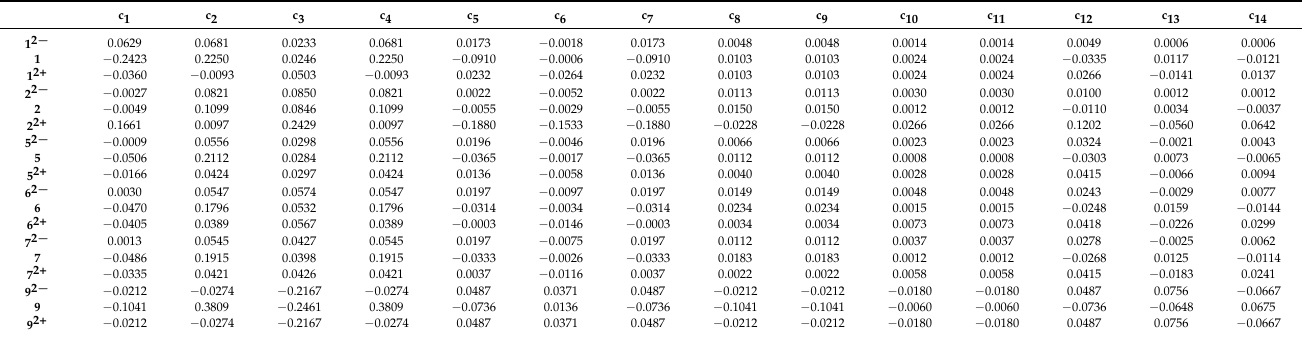
Table 2. CREs in units of | β | for quasicirculenes 1 , 2 , 5 − 7 , 9 and their double charged ions.